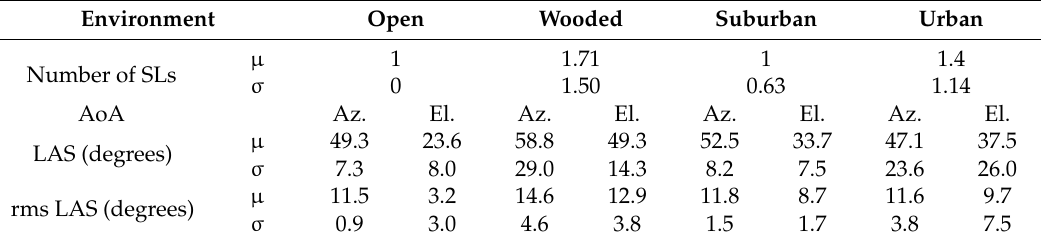
Table 3. Angular spread parameters.